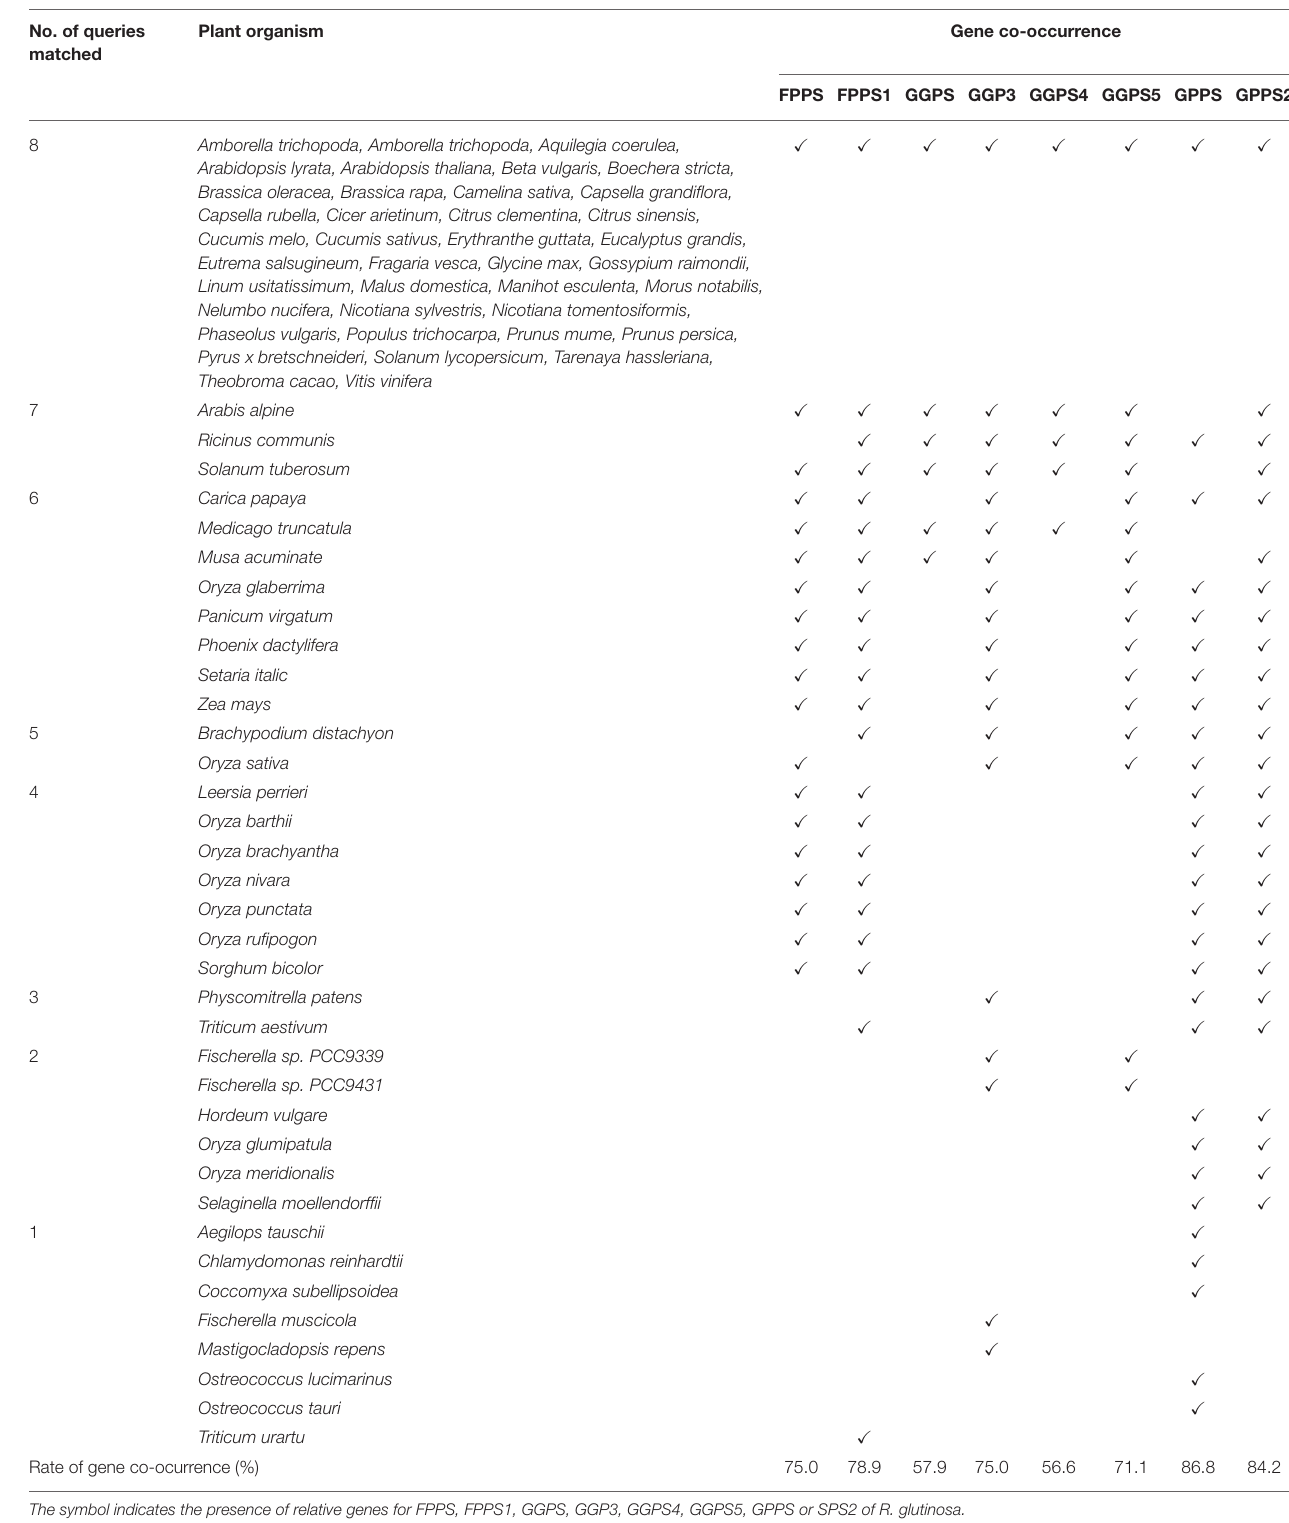
The symbol indicates the presence of relative genes for FPPS, FPPS1, GGPS, GGP3, GGPS4, GGPS5, GPPS or SPS2 of R. glutinosa.